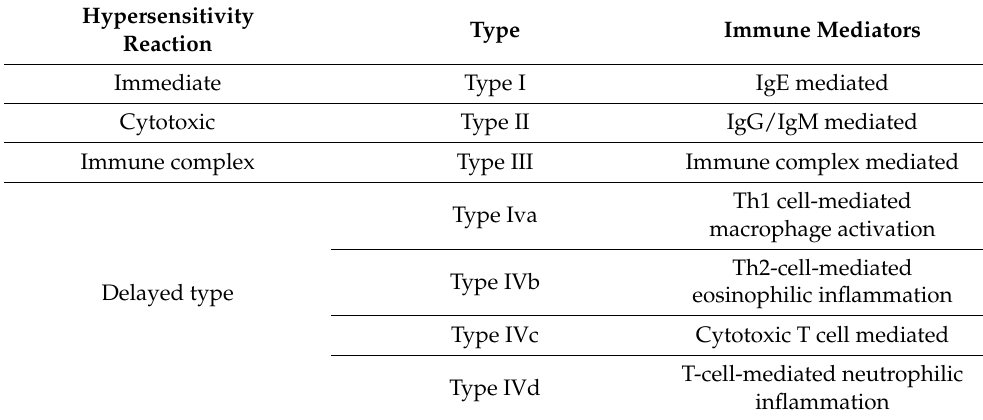
Table 1. Gell and Coombs Classification of hypersensitivity reactions.